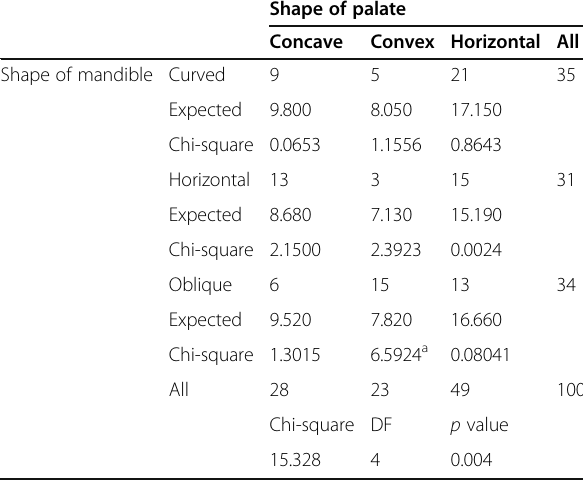
Table 2 Association between the shape of the palate and the shape of the mandible Shape of palate Concave Convex Horizontal All Shape of mandible